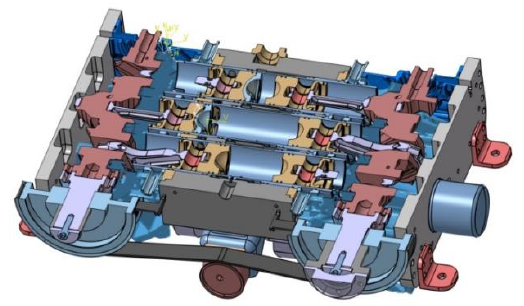
Fig. 1. Geometric model of the PZL-100 engine